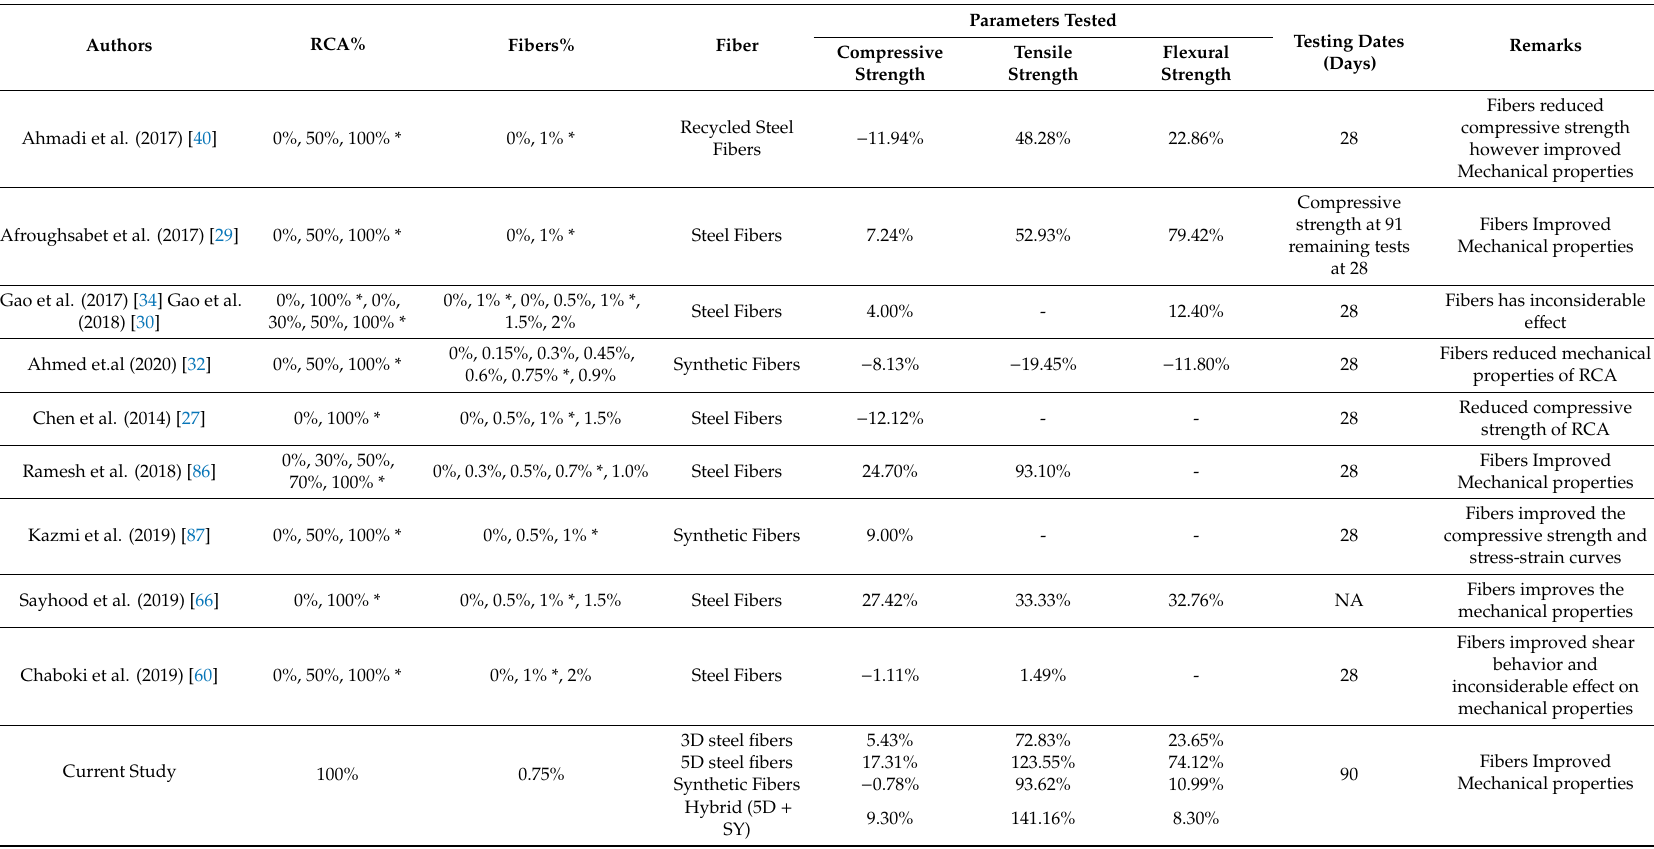
Table 11. Summary of mechanical properties of fiber reinforced recycled concrete from literature compared to the current study